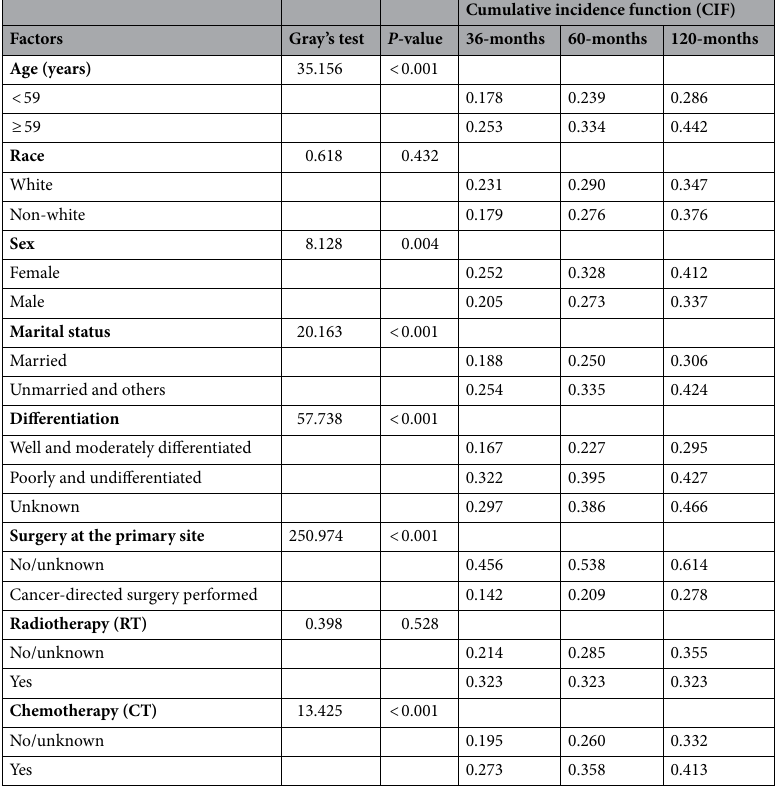
Cox regression analysis Fine ‐ Gray regression